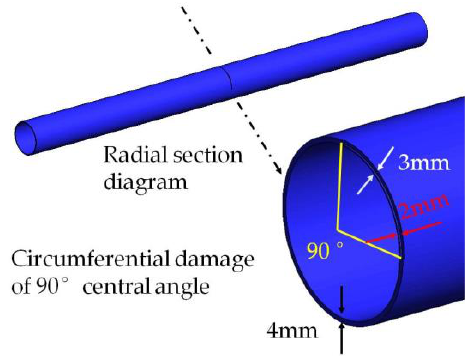
Figure 15. The cross-section of circumferential damage with a radius angle of 90°.